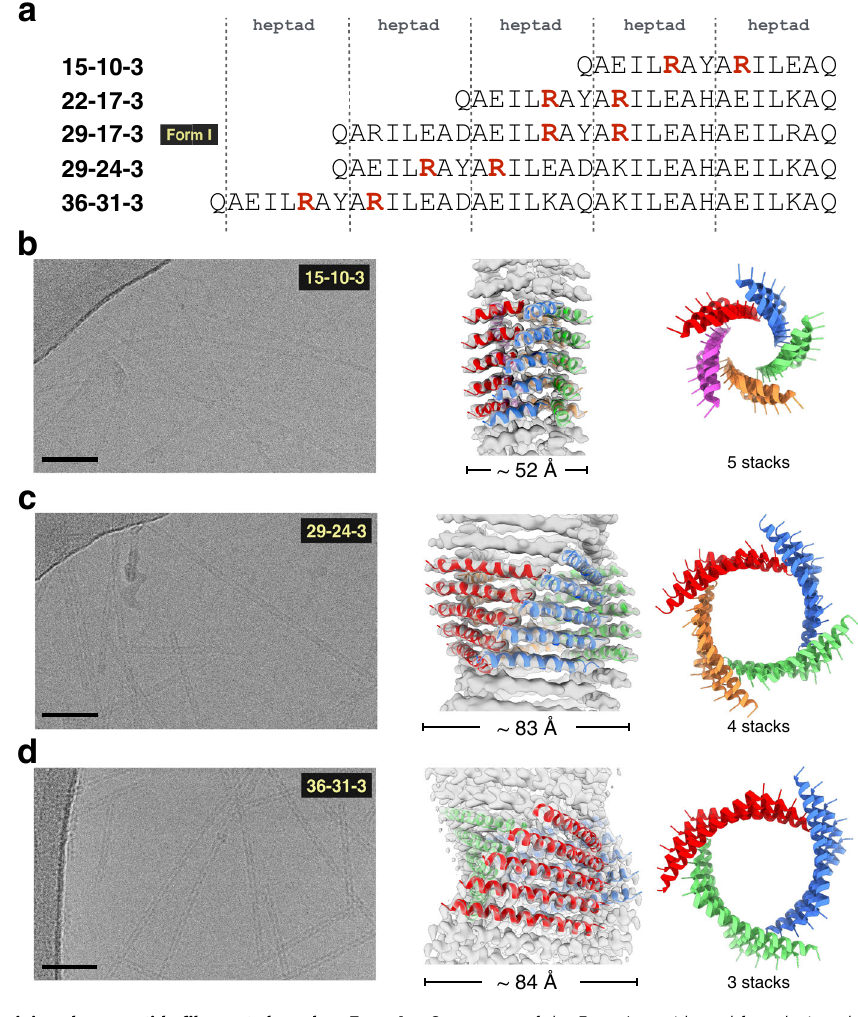
Fig. 2 Cryo-EM of arginine clasp peptide fi laments based on Form I. a Sequences of the Form I peptide and four designed peptides derived from Form I. b – d Cryo-EM of peptides 15-10-3, 29-24-3, and 36-31-3. Representative raw micrographs are shown on the left (scale bar 500 Å) out of a total number of 84, 279, and 314 images recorded, respectively. The cryo-EM reconstructions are shown in the middle, with models fi tted into the maps. The top views of the atomic models are shown on the